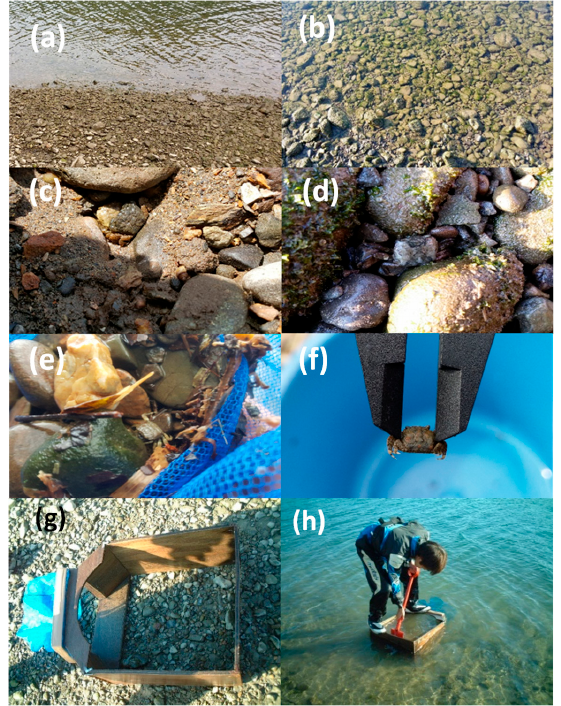
Figure 2. Proportions of all individuals of D. japonicus during the sampling periods.